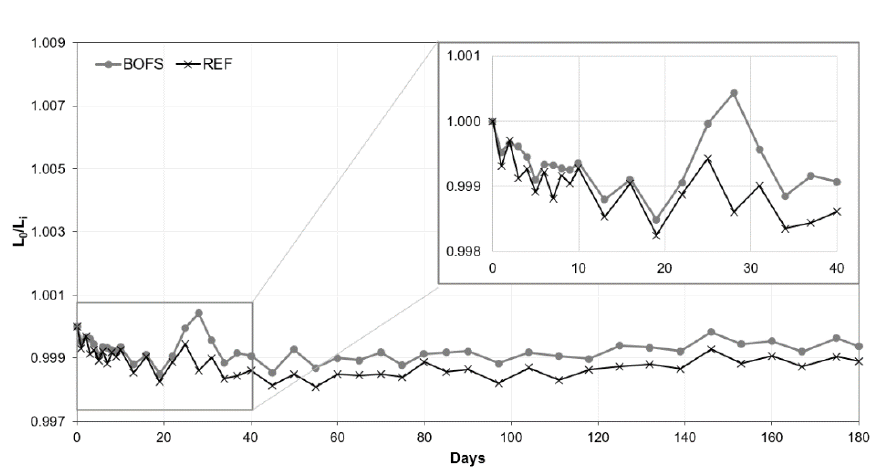
Figure 8. Expansibility of concrete specimens